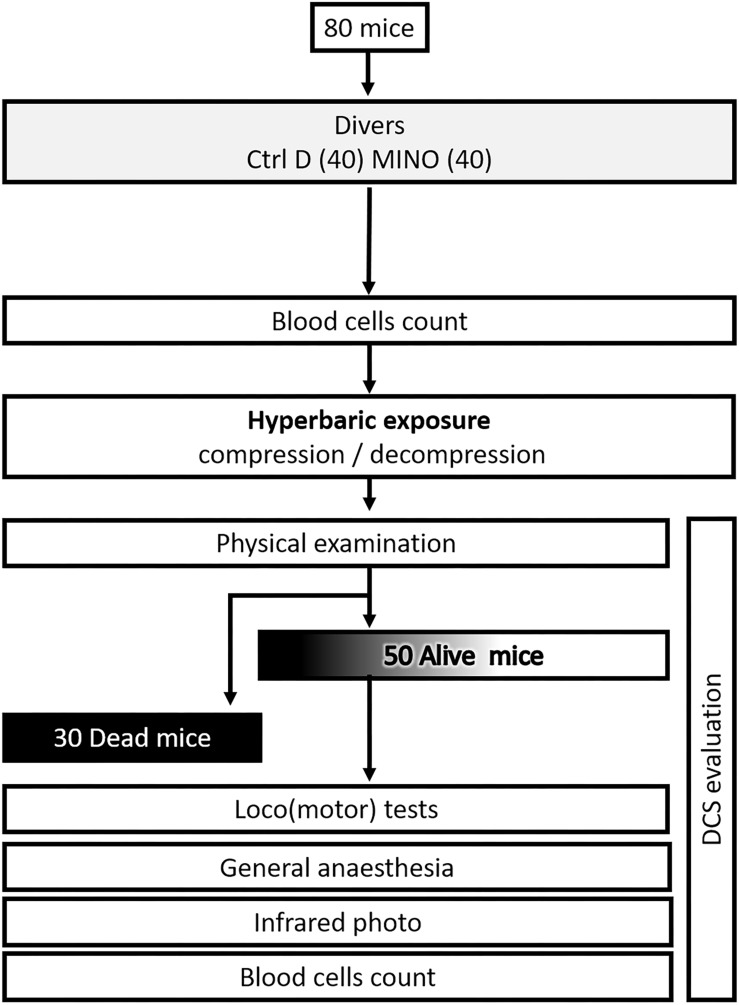
Flow chart process.